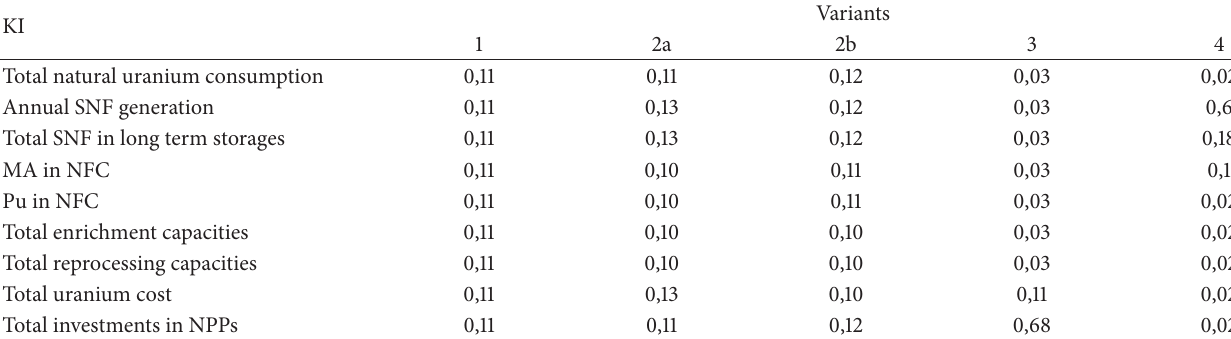
Table 4: Weights’ summary